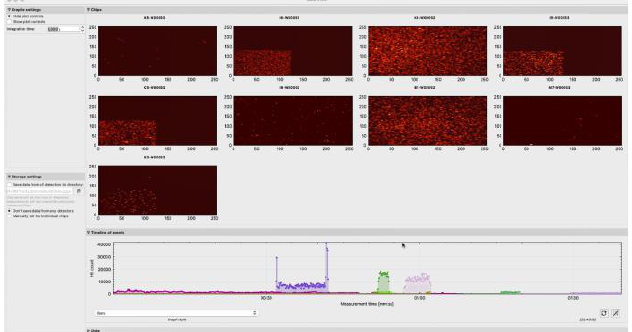
Fig. 2. Graphical user interface of the MM Track Lab MICADO detector network plugin. Individual matrices for all nine detectors measuring simultaneously are in the top part and the common timeline represents the number of events.